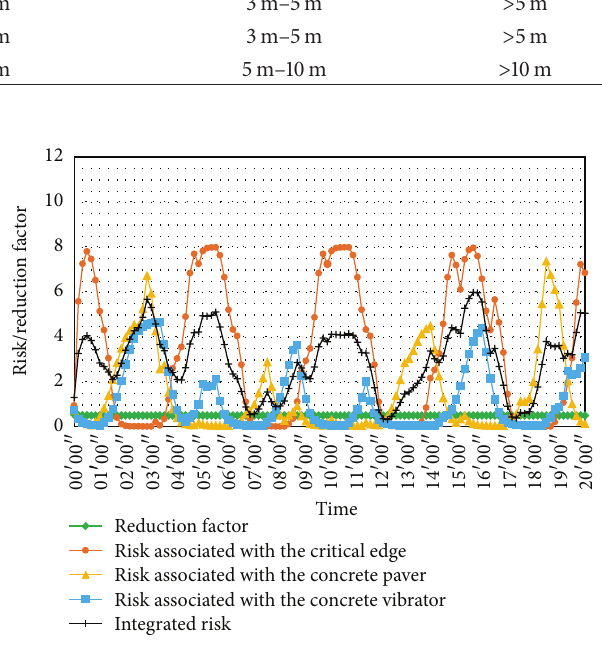
Figure 8: Real-time safety risks to a worker situated in the pouring area for a 20-minute